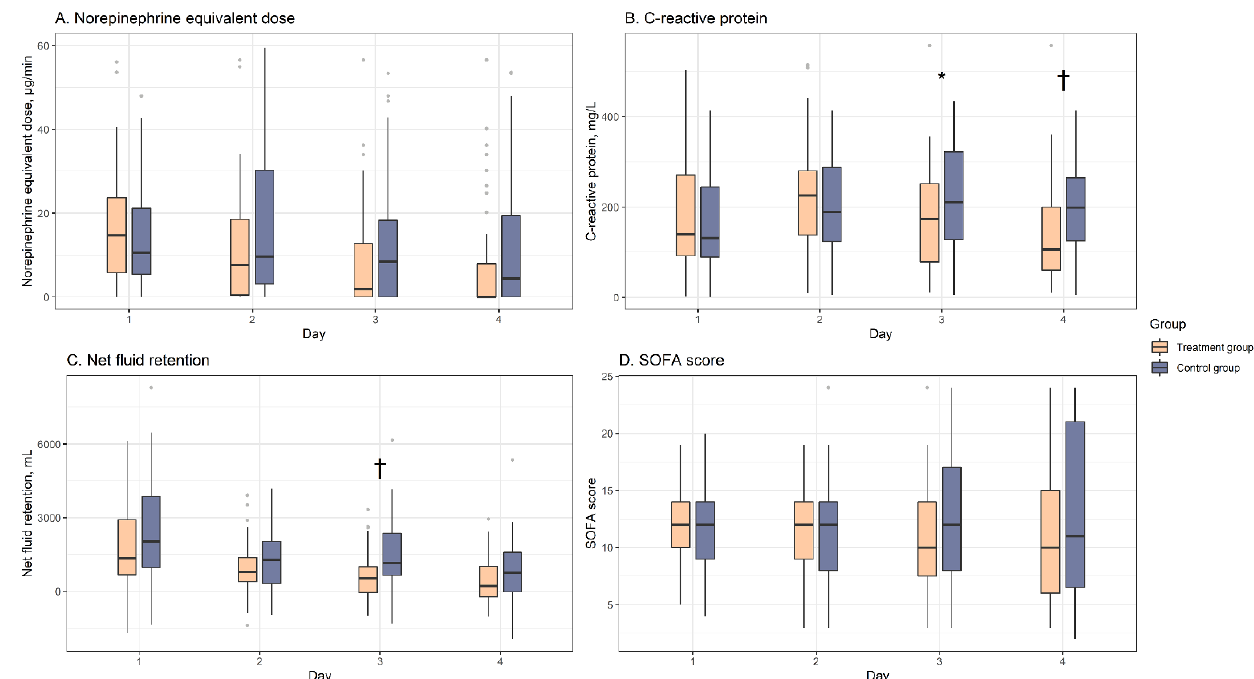
Figure 1. A: Vasopressor dosages (norepinephrine equivalents), B: CRP concentrations, C: net fluid retentions, D: SOFA scores during the 4-day study period. The center lines indicate the median values, the box tops and bottoms indicate the interquartile ranges, error bars indicate the overall ranges, and the dots indicate outliers. CRP: C-reactive protein; SOFA: Sequential Organ Failure Assessment. * p < 0.05, † p < 0.01 when the treatment and control groups were compared by the Mann–Whitney U test or Student’s t -test.